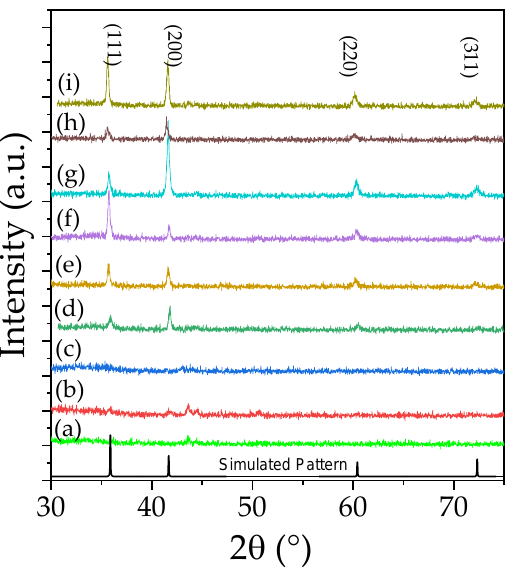
Figure 1. Diffraction patterns of TaN thin films deposited at different growth powers: (a) 120, (b) 150, (c) 160, (d) 170, (e) 180, (f) 190, (g) 200, (h) 210, and (i) 220 W. At the bottom (black line) simulated diffraction pattern.